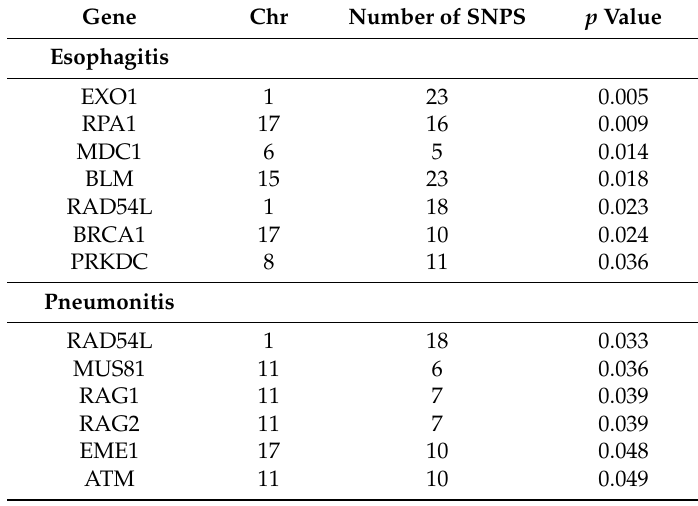
Table 6. VEGAS Results for the significant genes for radiation esophagitis and pneumonitis from discovery set. Gene Chr Number of SNPS p